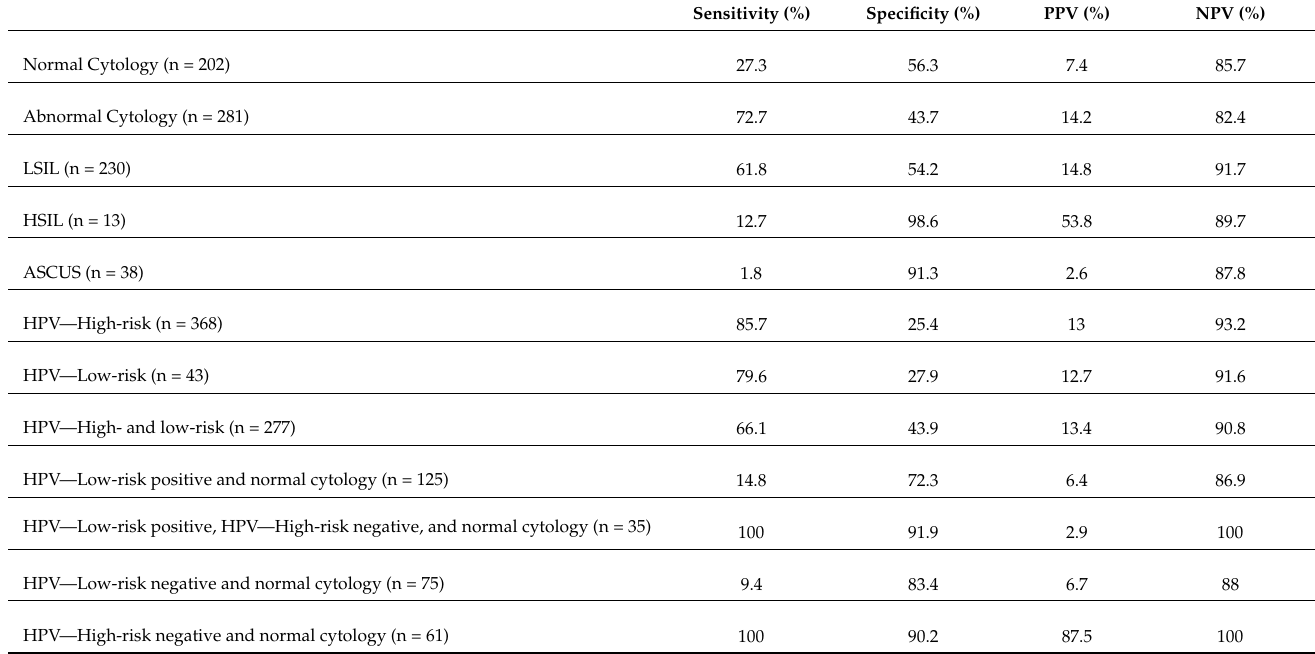
(Table 5). Correlations between biopsy, cytology, and HR and LR HPV PCR results for HSIL- plus never exceeded 0.4, the minimum value for analyzing agreement between techniques (Table 6). Table 5. Sensitivity, specificity, PPV, and NPV of anal cytology and HPV PCR for diagnosis of